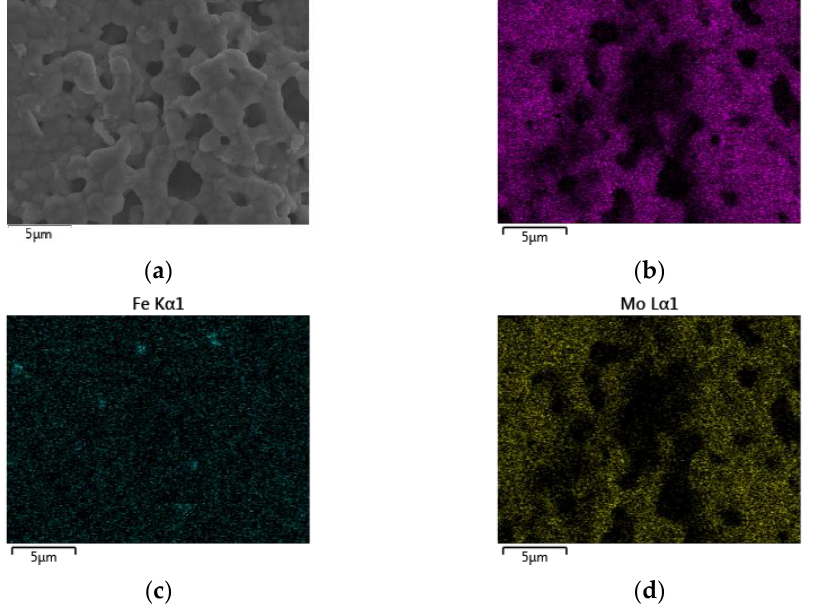
Figure 9. EDS mapping for a section of the sample F after the reduction process ( a ). A homogeneous distribution of strontium ( b ) and molybdenum ( d ) atoms can be observed while a non-uniform distribution of iron ( c ) atoms is obtained.